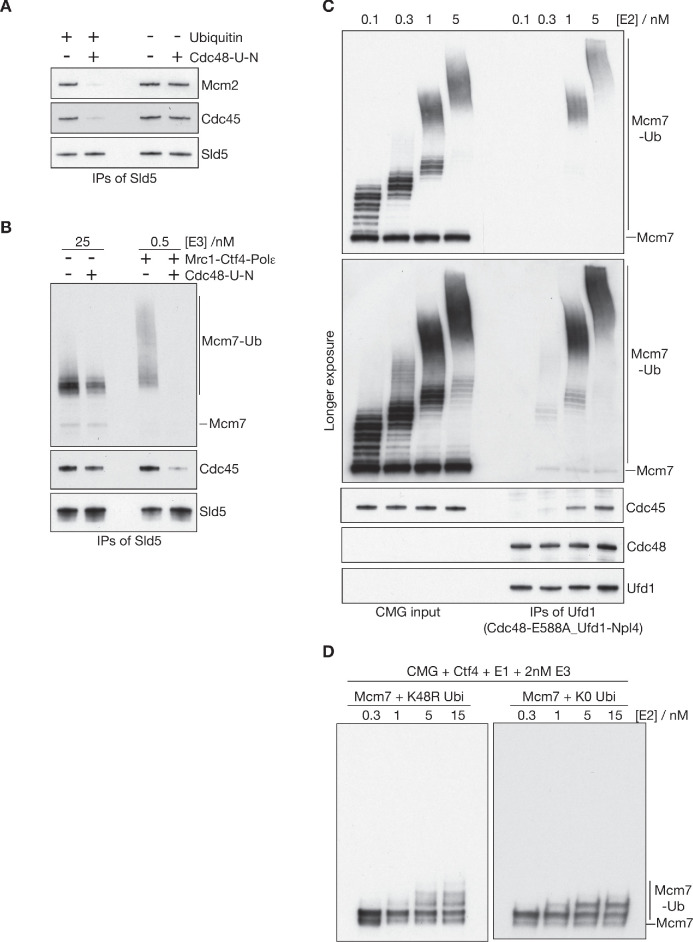
CMG helicase disassembly is dependent upon the formation of long K48-linked ubiquitin chains.(A) Similar reactions to those in Figure 4B were performed in the presence or absence of the indicated factors. (B) Analogous reactions to those in Figure 4C were carried out in the presence of 0.5 nM or 25 nM SCFDia2. (C) CMG was ubiquitylated in the presence of the indicated concentrations of E2. Subsequently, 50 nM Cdc48-E588A-Ufd1-Npl4 was added and the Cdc48-E588A-Ufd1-Npl4 complex was then isolated by immunoprecipitation of Ufd1. The indicated associated proteins were monitored by immunoblotting. (D) Ubiquitylation reactions in the presence of the indicated concentrations of E2, either with with K48R ubiquitin (left side) or or lysine-free ubiquitin (K0) (right side).